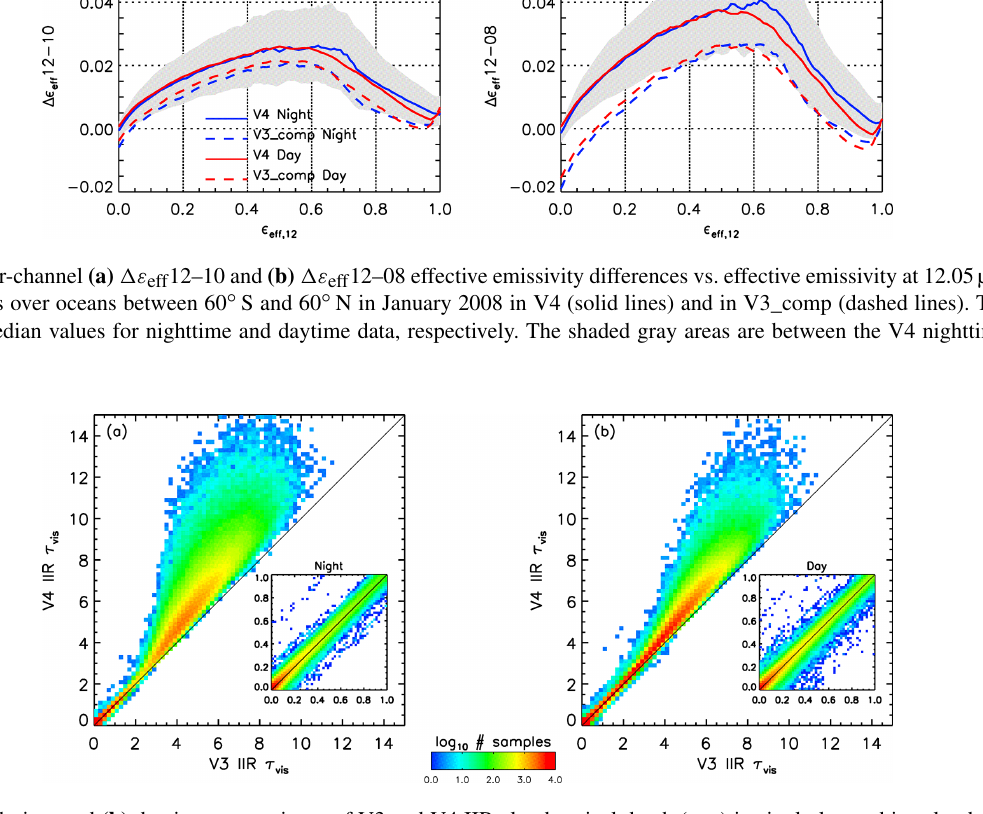
Figure 4. (a) Nighttime and (b) daytime comparisons of V3 and V4 IIR cloud optical depth ( τ vis ) in single-layered ice clouds over oceans between 60 ◦ S and 60 ◦ N in January 2008. The small embedded plots show details for τ vis between 0 and